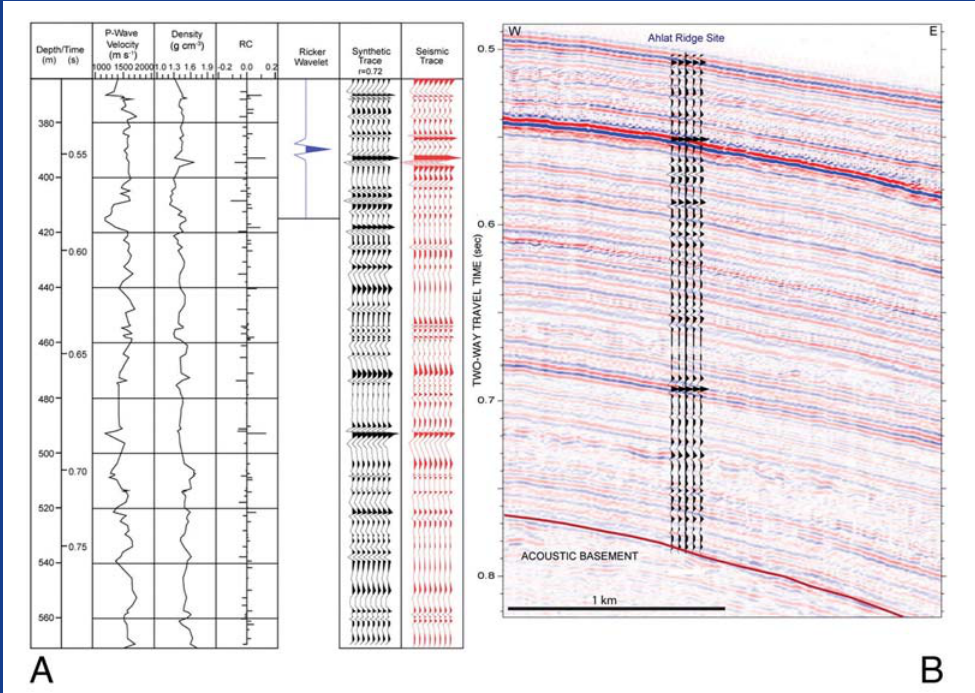
Figure 16. [A] Well to seismic calibration at Ahlat Ridge site. [B] Comparison of the well to seismic tie at Ahlat Ridge